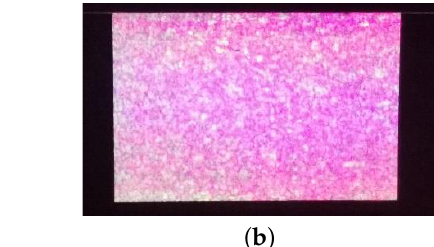
Figure 7. Homogeneity measuring illustration. ( a ) The 13 measuring points defined by ANSI [24,29]; ( b ) The measuring setup.